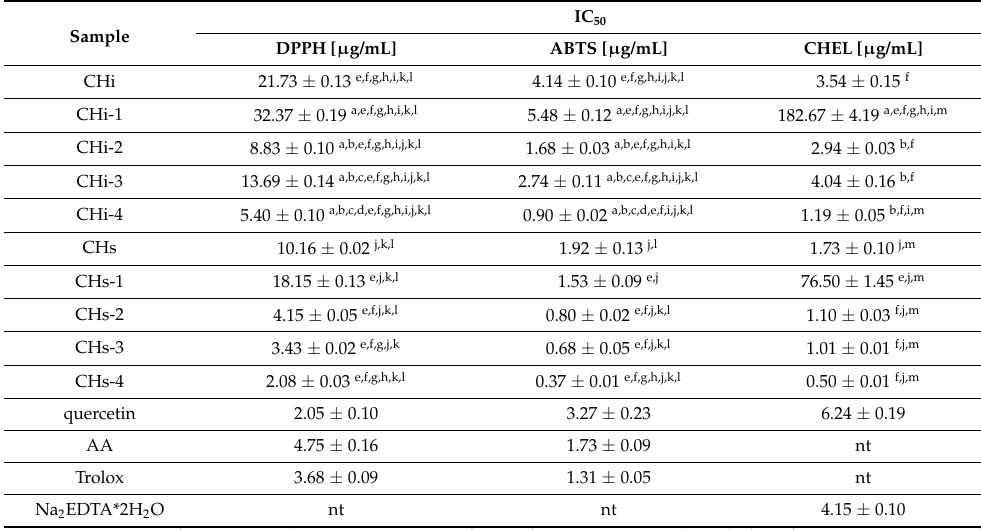
Table 6. The IC 50 values determined in antioxidant